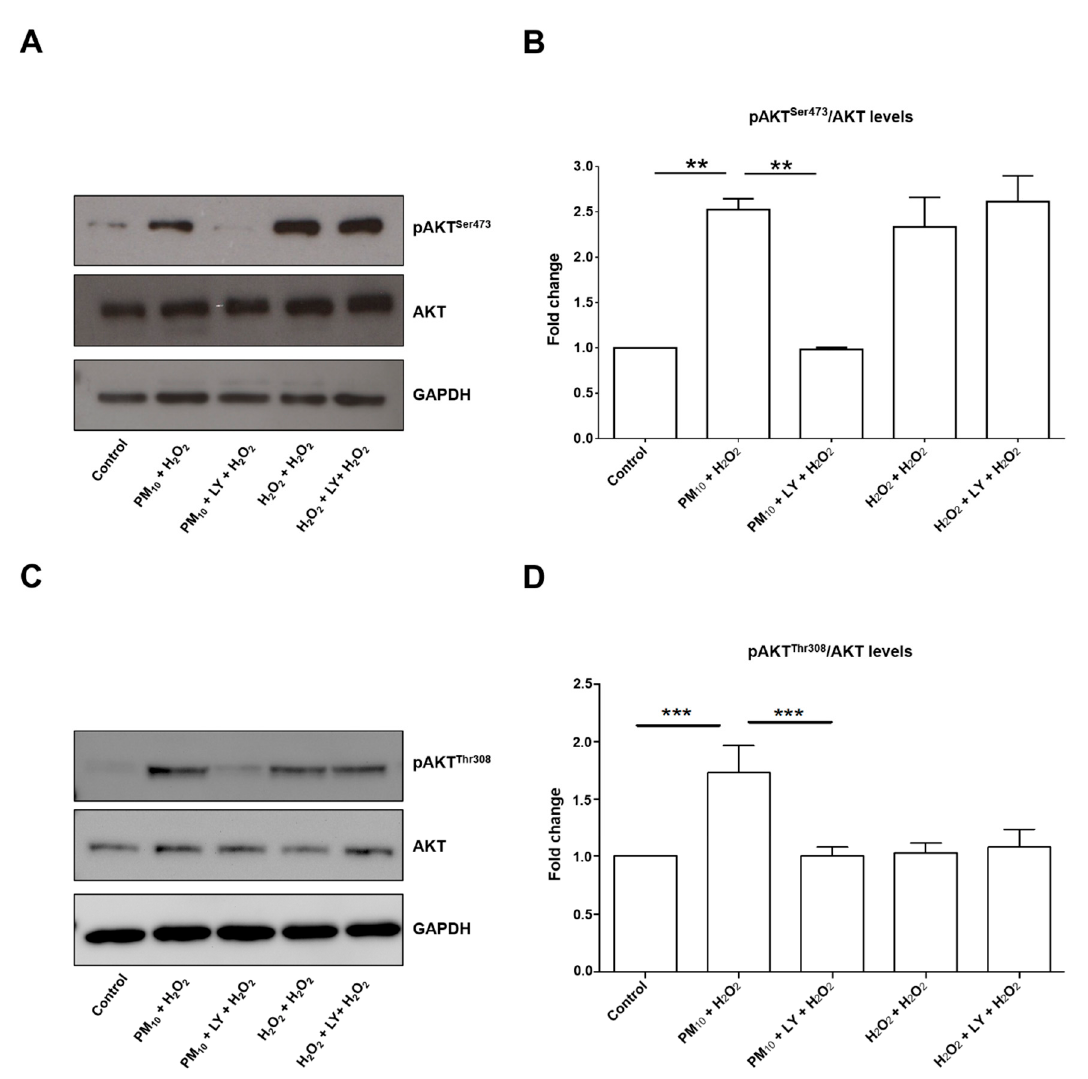
Figure 3. Representative blot of ( A ) pAKT Ser473 and total AKT, as well as ( C ) pAKT Thr308 and total AKT assessed by western blot and densitometry of ( B ) pAKT Ser473 and ( D ) pAKT Thr308 of levels using ImageJ software. Lung epithelial cells were pre-exposed to PM 10 (10 µ g / cm 2 ) for 24 h, and then cells were treated with H 2 O 2 (500 mM) for 24 h. In lane 3 and 6 of the blot (panel A) are cells treated with LY294002 inhibitor (50 µ M) for 1 h before the H 2 O 2 (500 µ M) treatment. Glyceraldehyde 3-phosphate dehydrogenase (GAPDH) protein was used as loading control for western blot. pAKT Ser473 ** p < 0.001 versus control; ** p < 0.001 versus PM 10 + H 2 O 2 versus PM 10 + LY + H 2 O 2 . pAKT Thr308 *** p < 0.0001 versus control; *** p < 0.0001 versus PM 10 + H 2 O 2 versus PM 10 + LY + H 2 O 2 . The image is representative of three independent experiments, and values are the mean ± SD of three independent experiments.